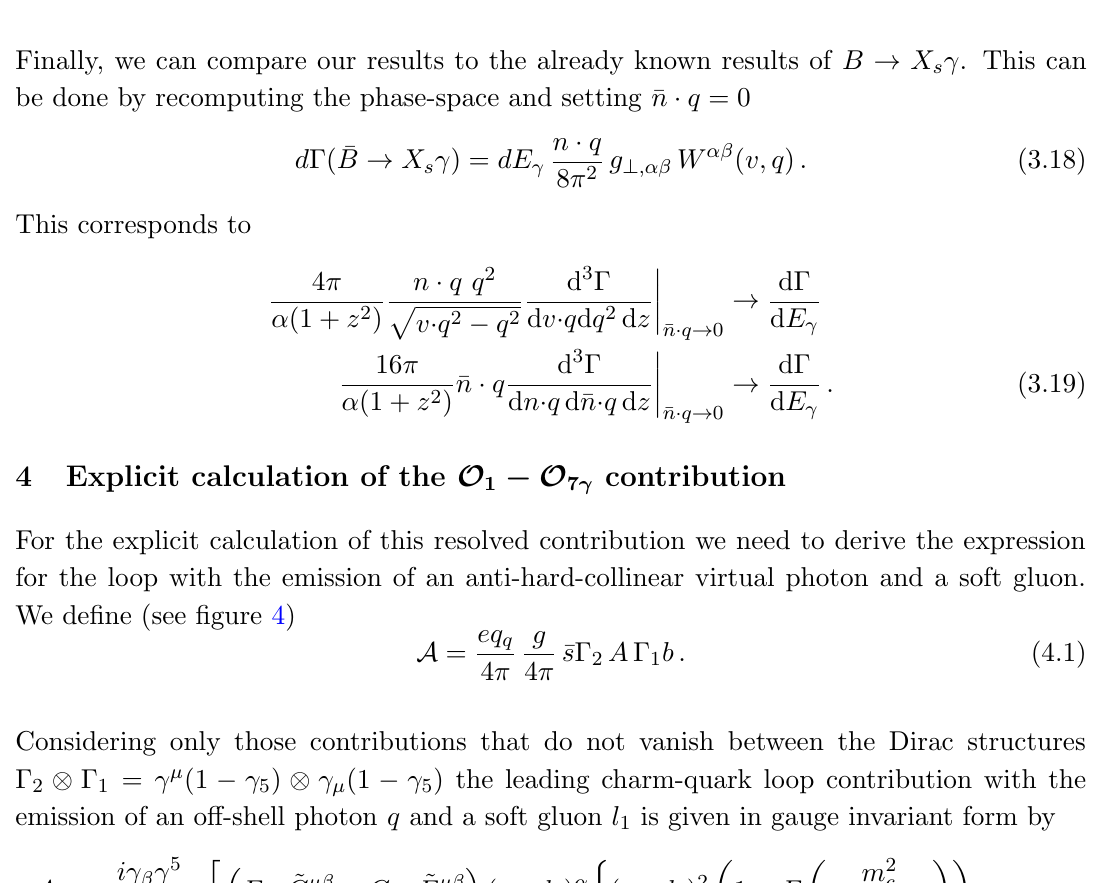
Figure 4 . Graphical illustration of the leading charm-quark loop contribution with the emission of an o(cid:11)-shell photon and a soft gluon induced by the